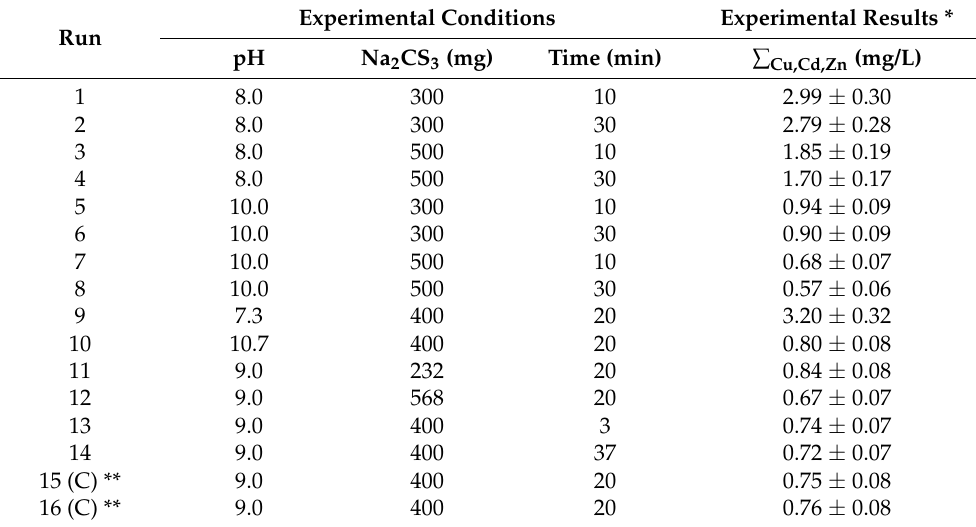
Table 1. Empirical conditions for the Central Composite Design/Response Surface Methodology